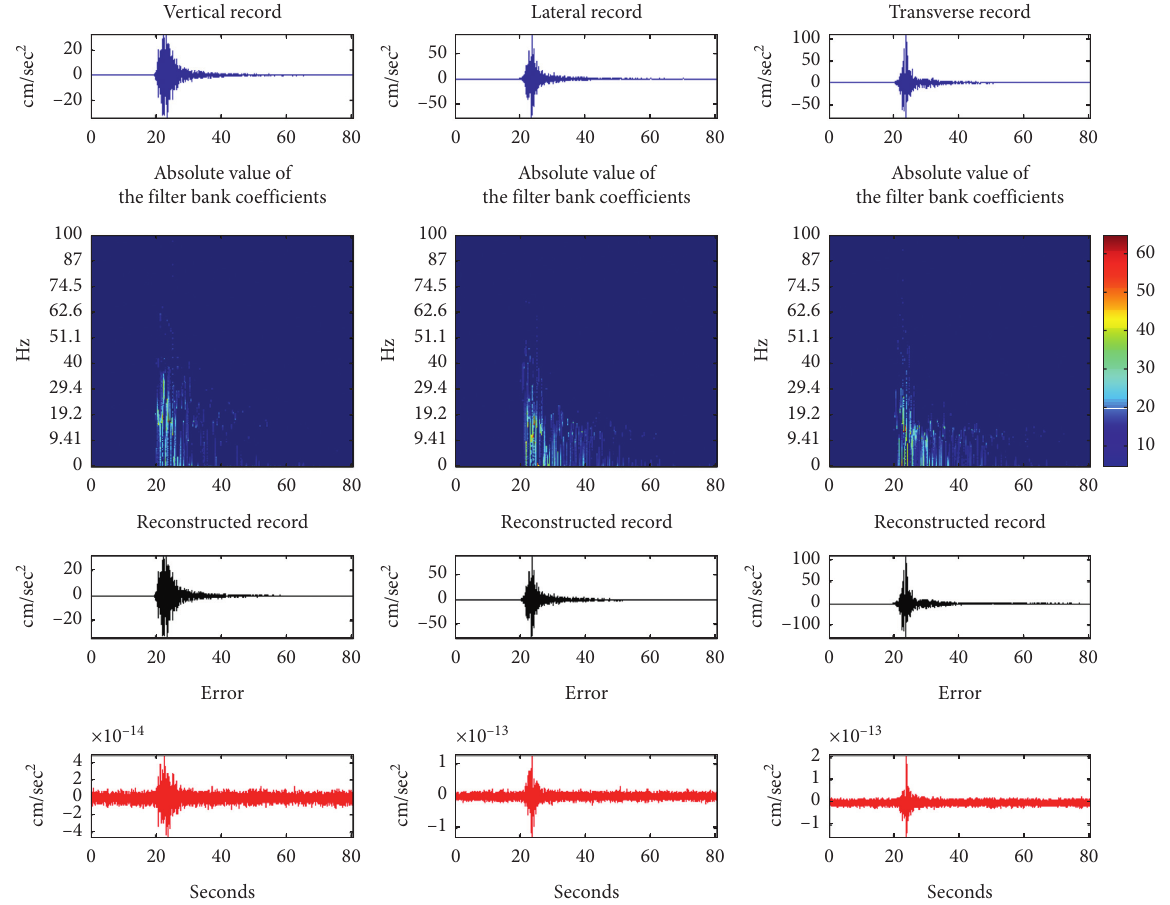
Figure 9: ERBlet filter bank synchrosqueezing analysis of the Mosha 2020 earthquake accelerograms recorded in Mosha3